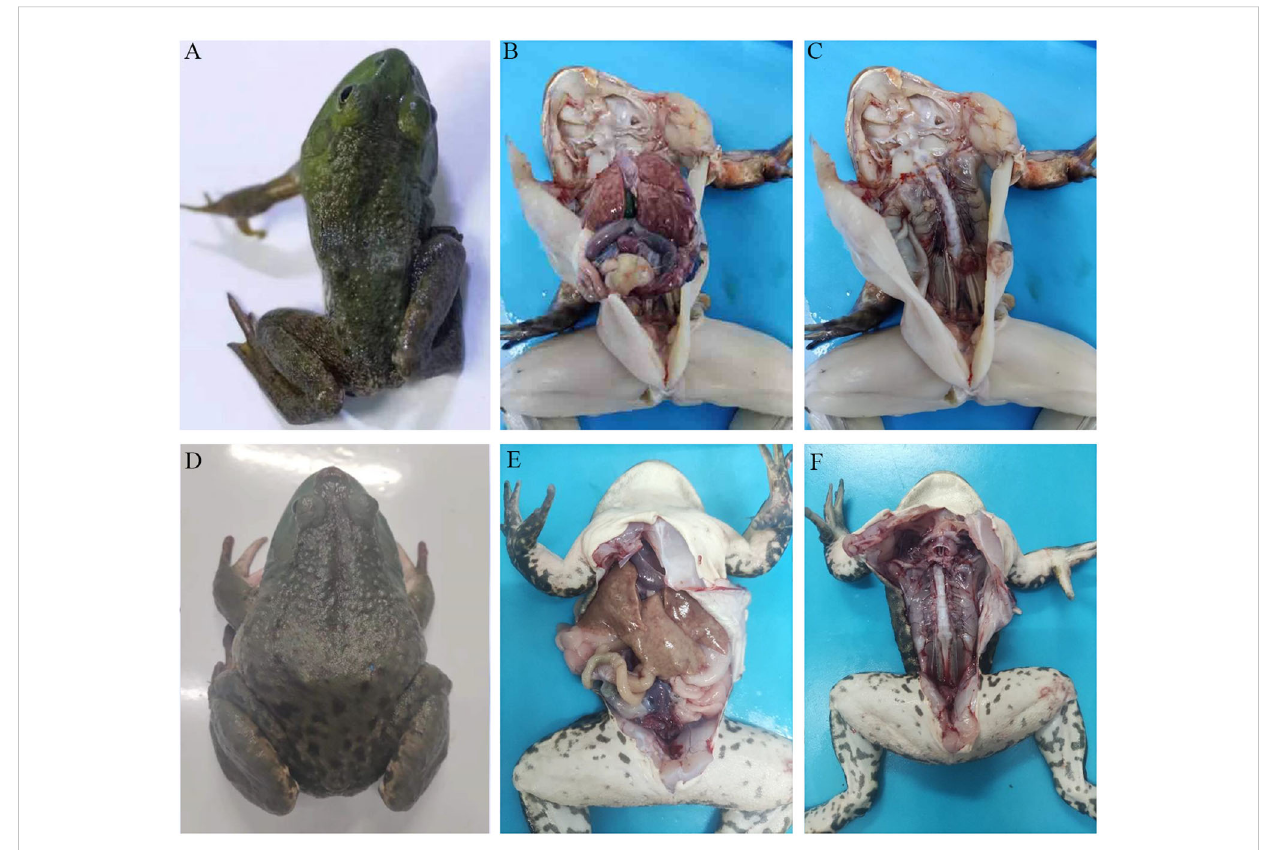
FIGURE 1 Clinical features of a bullfrog epidemic meningitis-like disease. The diseased bullfrogs showed serious torticollis (A) , the liver, spleen, and kidney were enlarged (B) , and the spine of one frog was curved (C) . The healthy bullfrog neck (D) , liver, spleen, kidney (E) , and spine (F) are